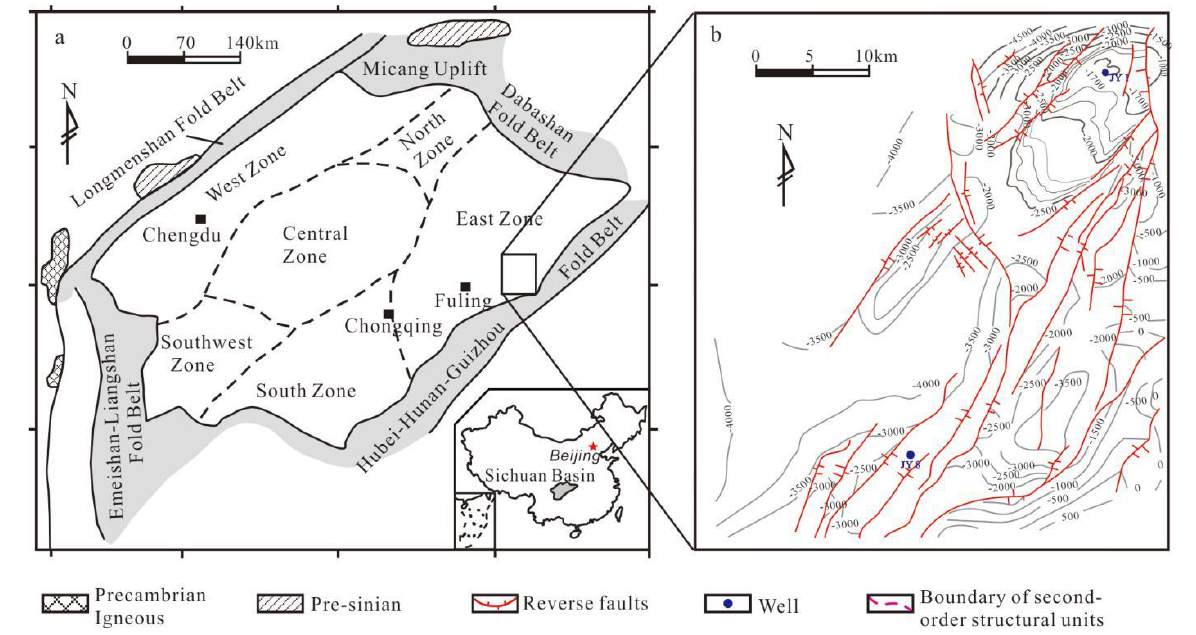
Figure 1. Location structure of study area. ( a ) Regional division of Sichuan Basin, ( b ) Structural plan of Jiaoshiba area.